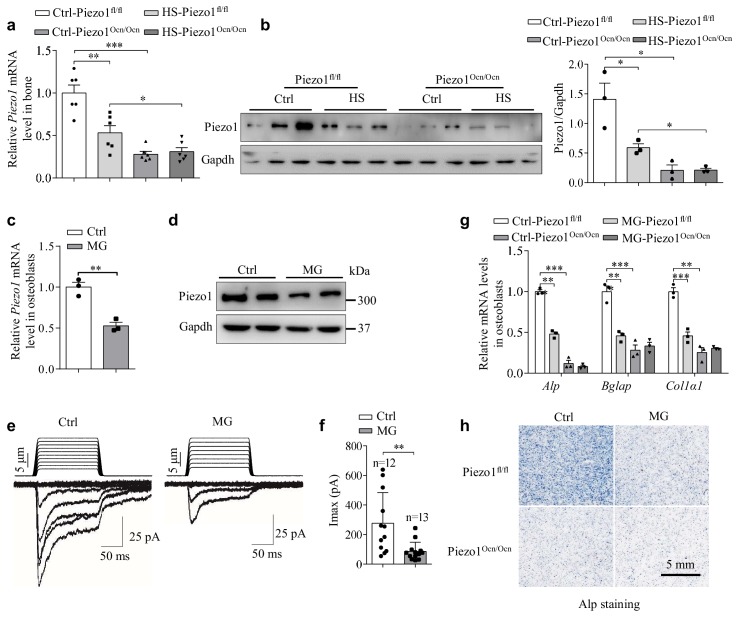
Mechanical unloading suppresses Piezo1 expression in Piezo1Ocn/Ocn mice and osteoblasts.(a, b) QRT-PCR analysis of Piezo1 mRNA level (a) and western blot analysis of Piezo1 protein level (b) in bone tissues from the groups of mice with the indicated treatment conditions. (c, d) QRT-PCR analysis of Piezo1 mRNA level and western blot analysis of Piezo1 protein level in osteoblasts under control (Ctrl) and simulated microgravity (MG) conditions. (e) Representative traces of poking-induced inward currents recorded at −60 mV in osteoblasts under Ctrl and MG conditions. (f) Scatter plots of the maximal poking-induced currents in osteoblasts under Ctrl and MG conditions. (g) QRT-PCR analysis of Alp, Bglap and Col1α1 mRNA levels in primary osteoblasts isolated from Piezo1fl/fl and Piezo1Ocn/Ocn mice under Ctrl and MG conditions. (h) Representative images of Alp staining in osteoblasts isolated from the indicated mice under Ctrl and MG conditions. Scale bar: 5 mm. All data are the mean ± s.e.m. from three independent experiments. **, p<0.01; ***, p<0.001.10.7554/eLife.47454.017Figure 5—source data 1.The data and statistical analysis of the effect of mechanical unloading on Piezo1 expression in osteoblasts.